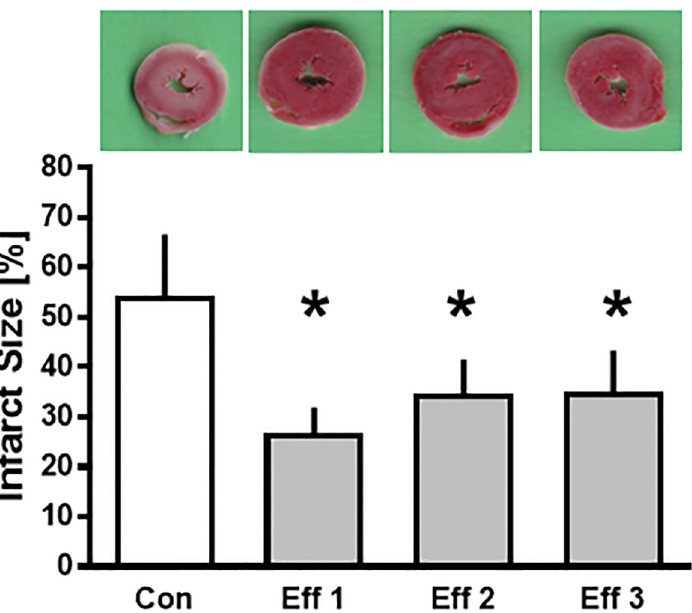
Fig 2. Infarct size measurement. Histogram shows the infarct size of controls (Con) and administration of effluent after IPC (Eff 1, Eff 2, Eff 3). Data are presented as mean ± SD, � P < 0.05 vs. Con. Representative TTC stained slices of the respective hearts.